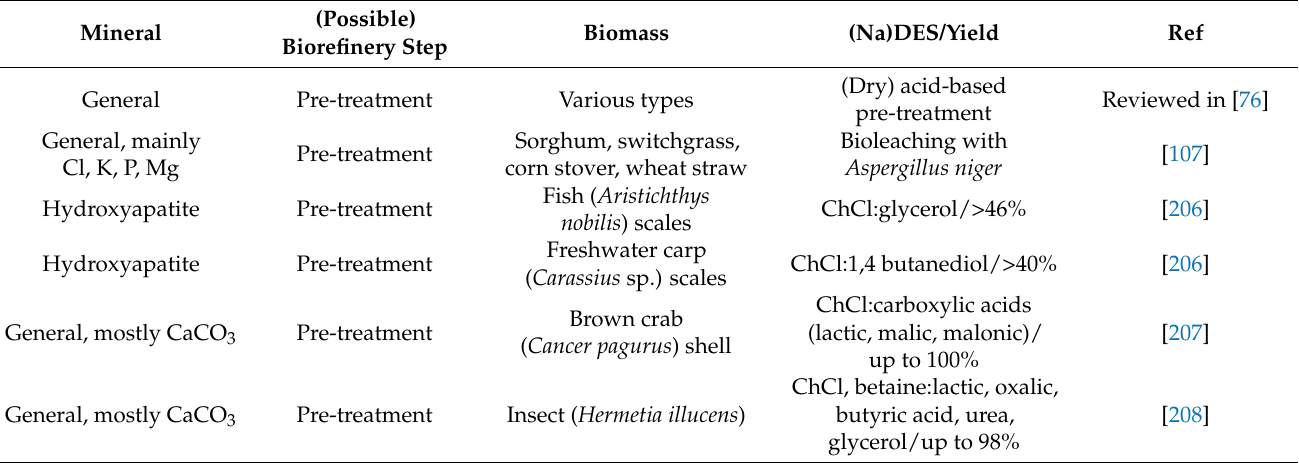
Table 1. Investigated methods for mineral recovery during the first stages of